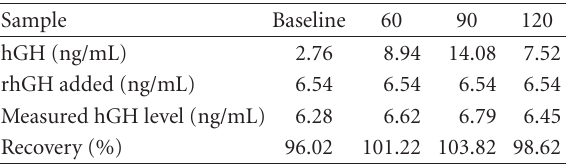
Table 2. Analytical recovery of